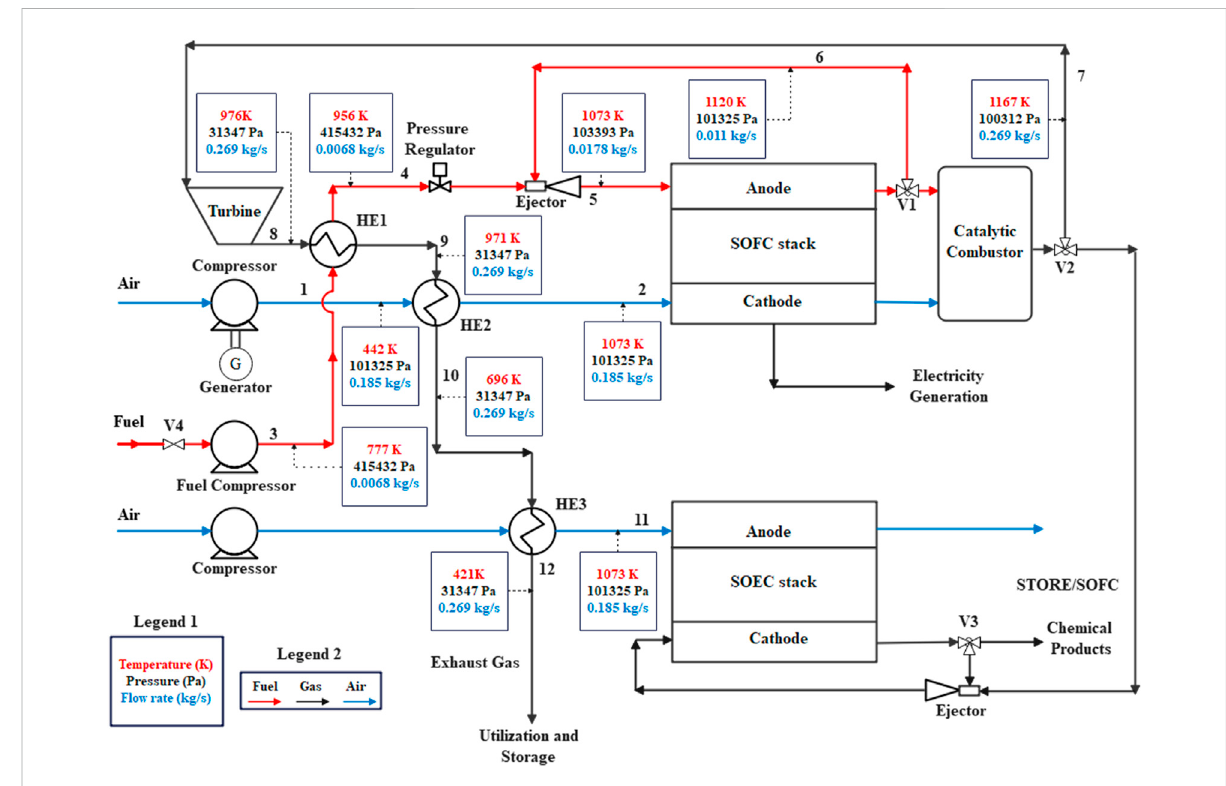
FIGURE 1 Con fi guration of IGFC hybrid system combining ejectors and